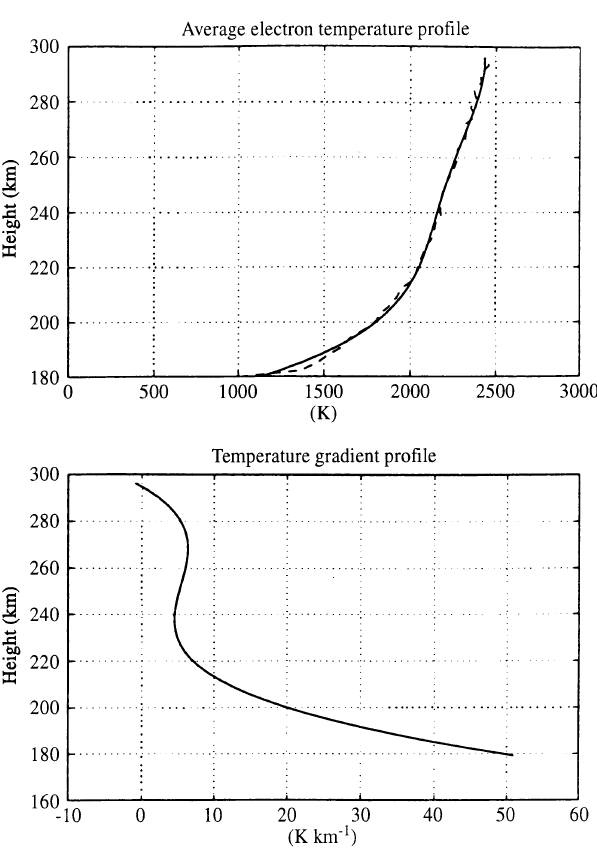
Fig. 9. Average electron-temperature profile for the considered peri- od in dashed line and the polynomial approximation, and the de- duced profile for